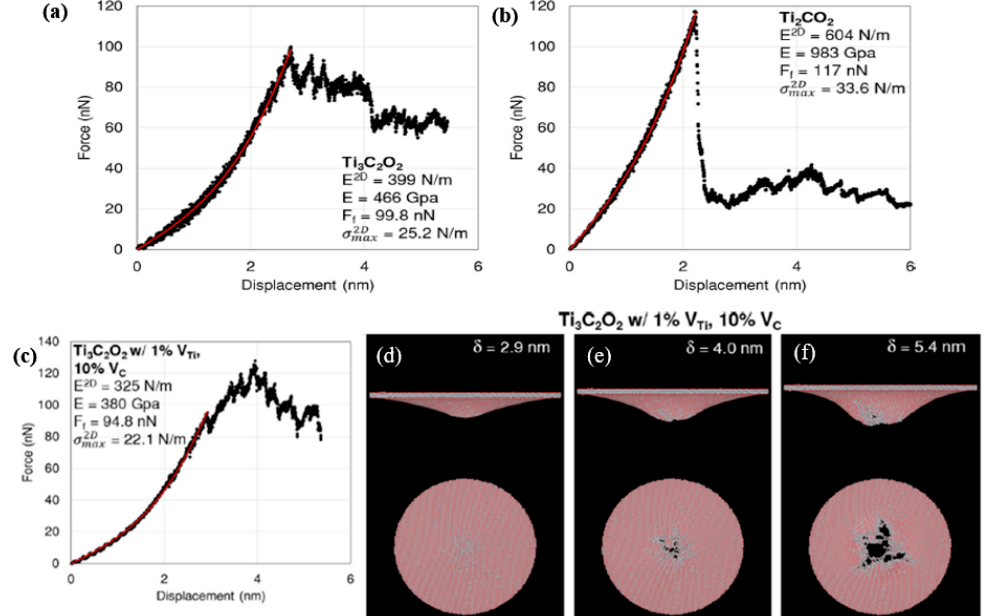
Figure 3. Force-Displacement curves for pristine monolayers of Ti 3 C 2 O 2 ( a ) and Ti 2 CO 2 ( b ). ( c ) A representative force-displacement curve. ( d – f ) photographs are showing the progressive indentation and fracture of the same representative Ti 3 C 2 O 2 monolayer with 1% V Ti and 10% V C . Reproduced with permission from [ 32 ] Copyright Elsevier, 2019.